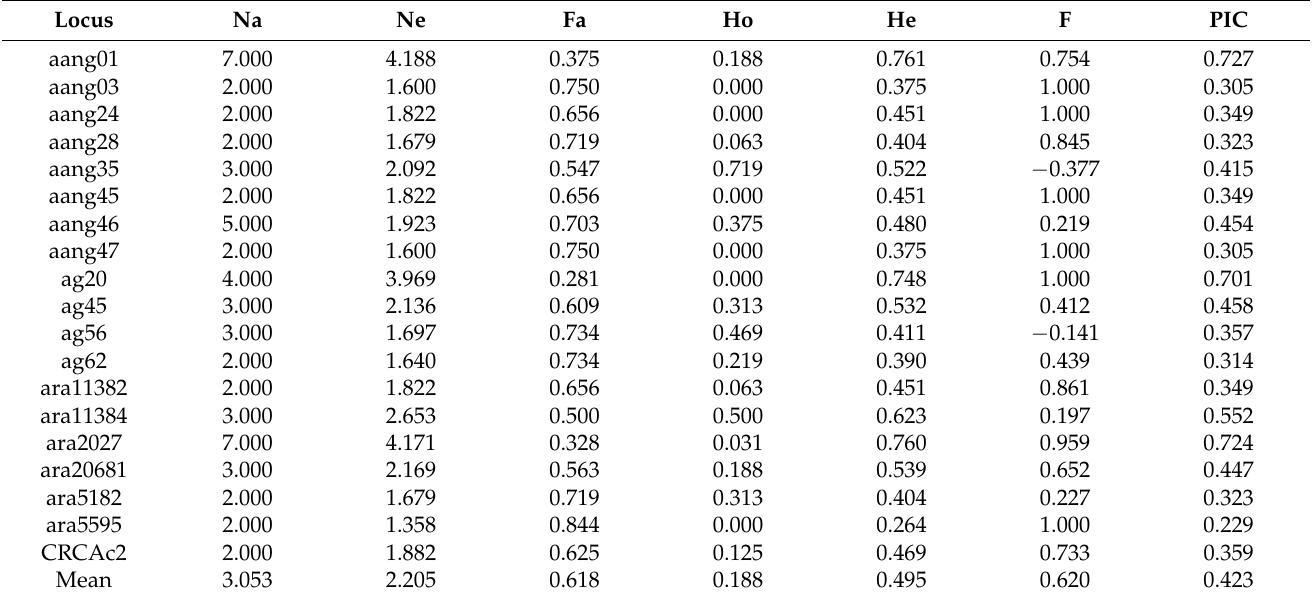
Table 4. Genetic parameters of the 19 polymorphic loci in 32 A. araucana accessions. For each locus, the number of alleles (Na), the effective number of alleles (Ne), the frequency of the predominant allele (Fa), the observed (Ho) and expected heterozygosity (He), the fixation index (F) and the polymorphic information content (PIC) are reported.